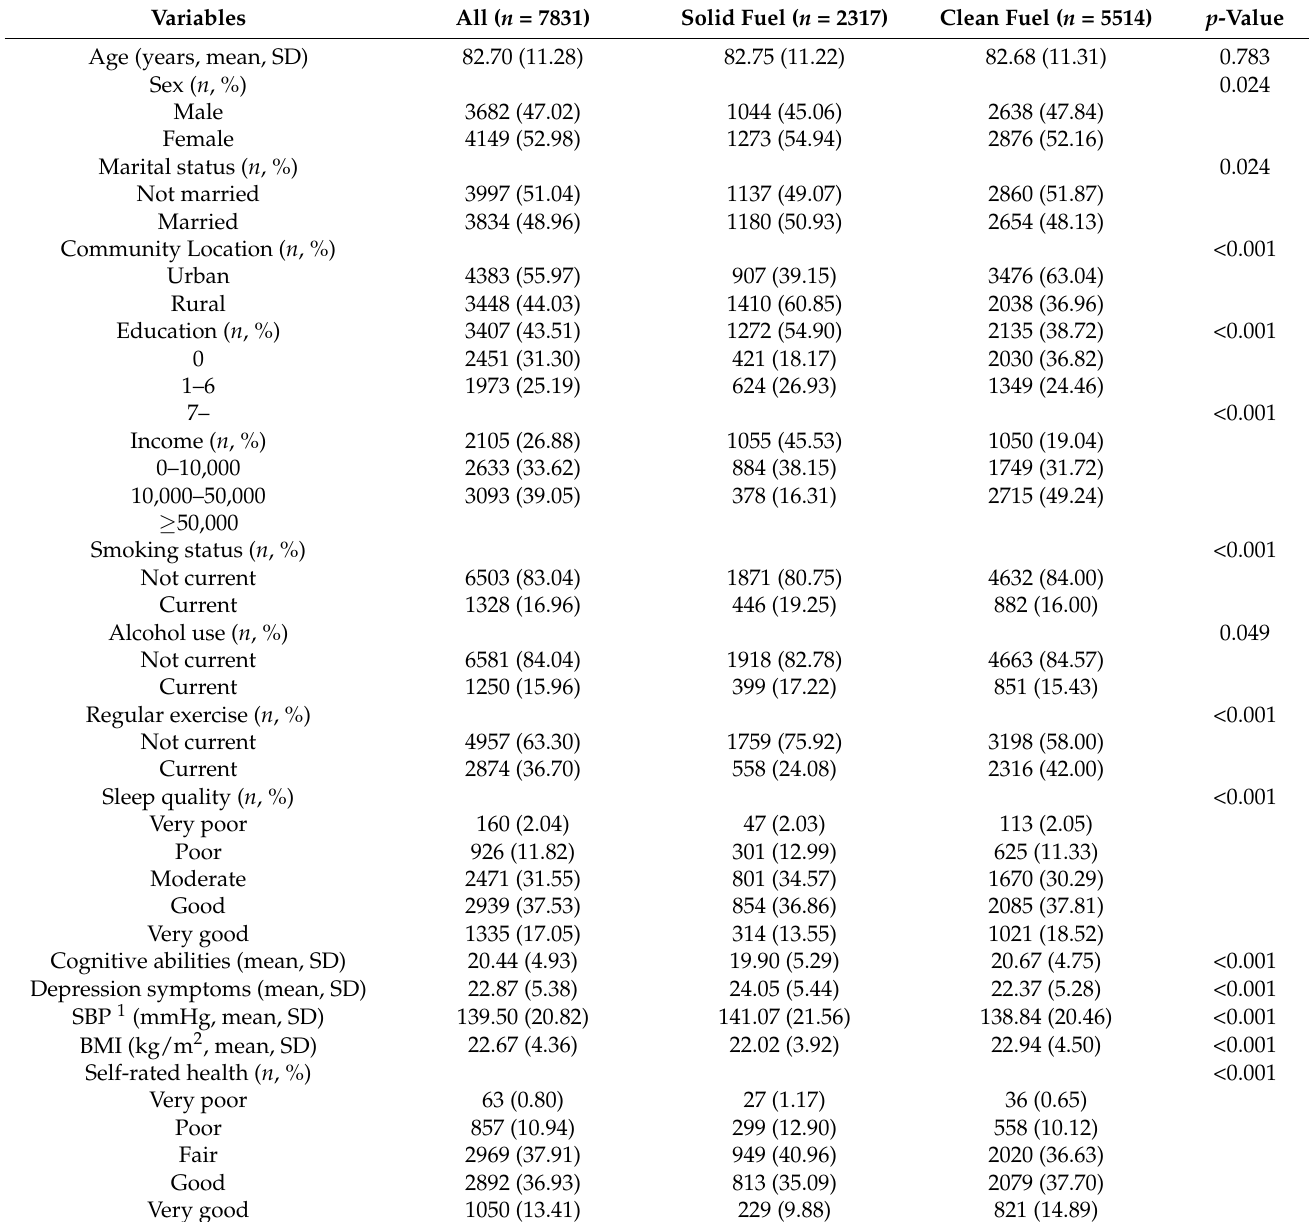
Table 1. Characteristics of selected variables among the